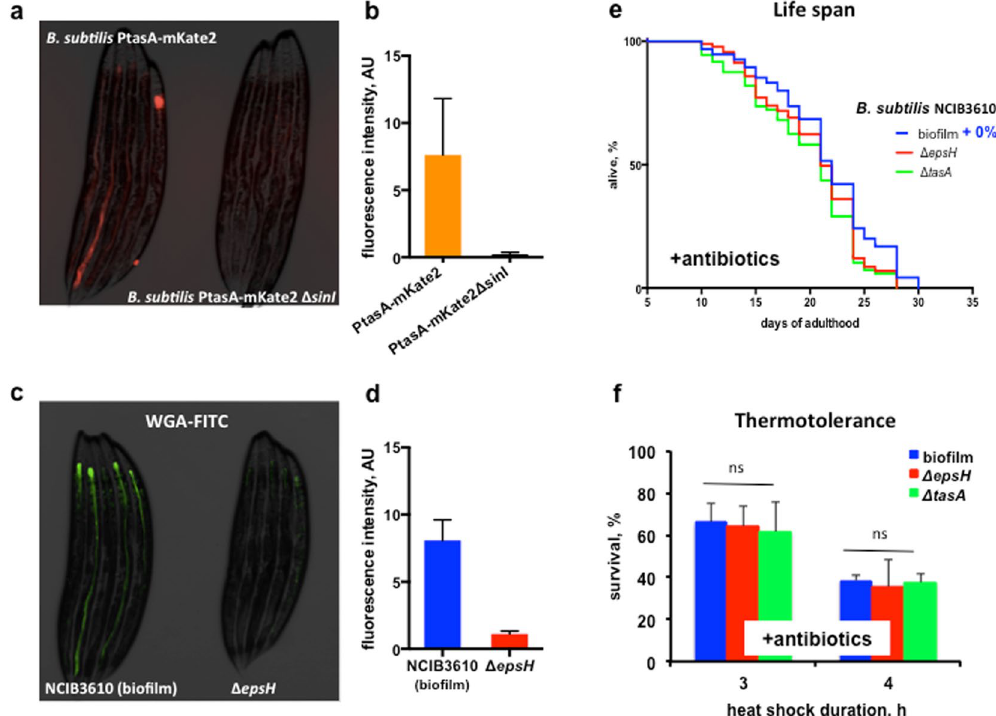
Figure 3. Beneficial effects likely require intestinal biofilm production. ( a ) Induction of biofilm matrix gene expression in the C. elegans intestine. Representative image of worms grown on the indicated B. subtilis strains were visualized at day 5 of adulthood. The red fluorescent signal indicates tasA expression in B. subtilis cells. ( b ) Fluorescence quantification of five-day old adults (n = 15) grown on corresponding bacterial strain. ( c ) Biofilm matrix exopolysaccharides are present in the C. elegans intestinal lumen. Representative image of FITC- conjugated wheat germ agglutinin (WGA-FITC) stained C. elegans grown on the indicated B. subtilis strains at day 5 of adulthood. Green fluorescence indicates biofilm matrix. ( d ) Fluorescence quantification of adult worms (n = 15) grown on corresponding bacterial strains until day 5 of adulthood and stained with WGA-FITC. Error bars show means ± SD from three independent experiments. ( e ) The anti-aging effect of biofilm requires live metabolizing bacteria. B. subtilis strains were grown on NGM plates overnight at 20 °C and then treated with a mixture of antibiotics (100 μ g/ml kanamycin and 500 μ g/ml carbenicillin). The graph is representative of three independent biological replicates. Median lifespan, days: biofilm–21; Δ epsH –21; Δ tasA –21. The log-rank